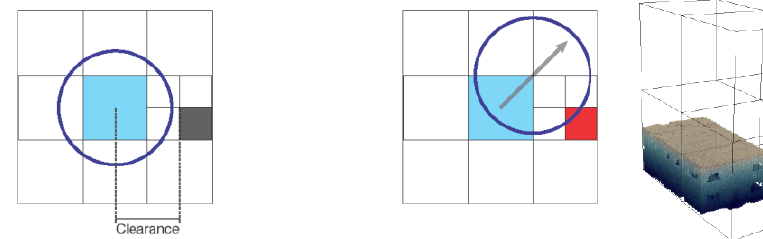
Figure 11: Pre-processing the point cloud